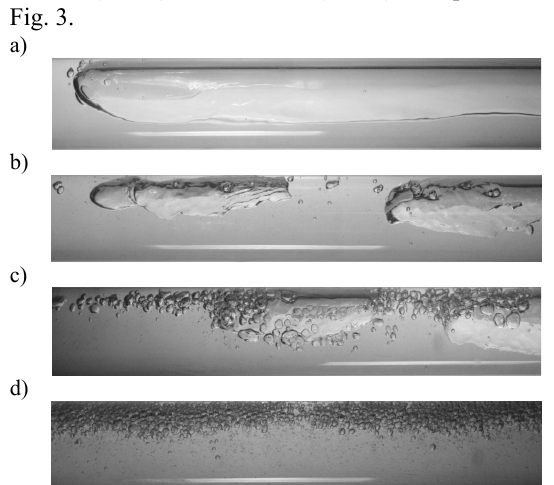
Fig. 3. Examples of the analysed flow structures: a) slug flow (LIW5), b) plug flow (LIW4), c) transitional plug – bubble flow (LIW2), d) bubble flow (LIW1).